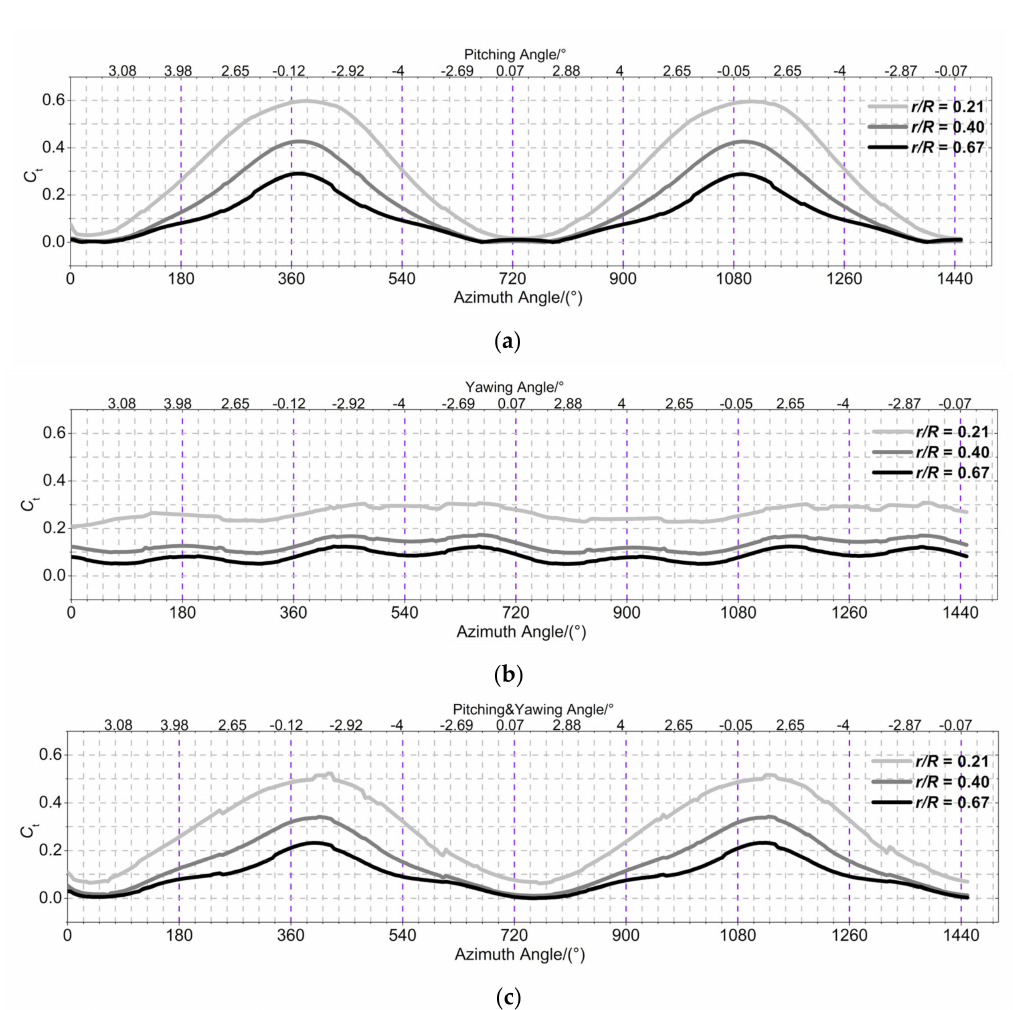
Figure 14. Variation in tangential force coefficient at different spans for the platform motions. ( a ) pitch motion; ( b ) yaw motion; ( c ) coupled pitch–yaw